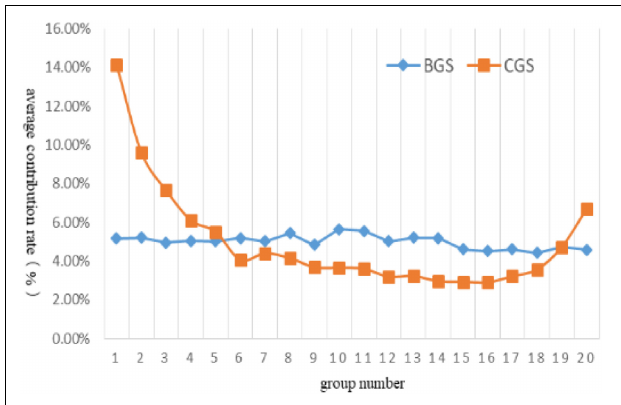
FIGURE 3 | The average contribution rate of each group updating P g .